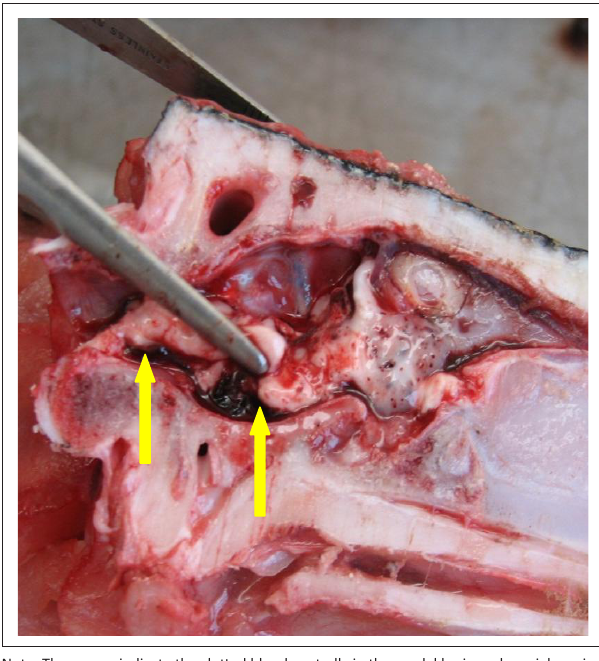
FIGURE 8: Mid-sagittal section through the head and neck of a crocodile that developed complications after blood